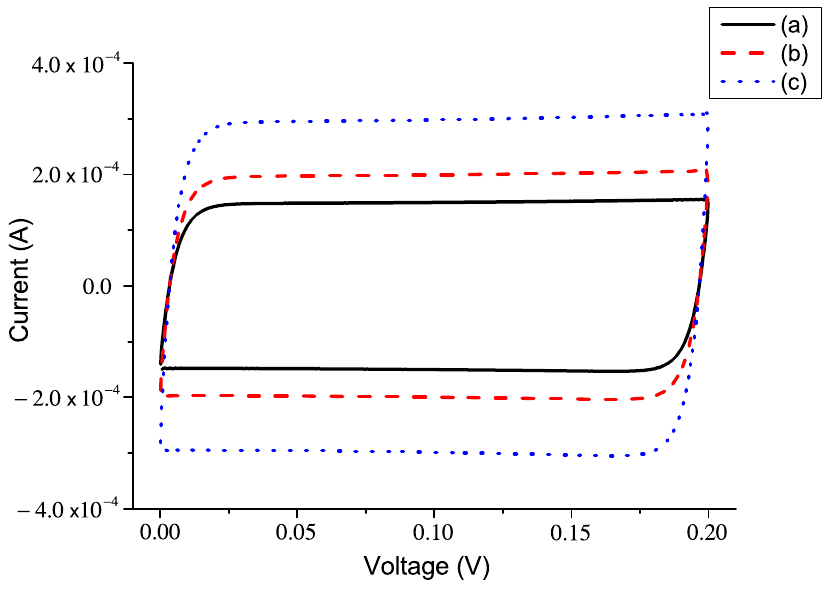
Figure 6. Effect of different adsorption coefficients on the two surfaces on the I = I ( V ) curve. The two electrodes have the same adsorption properties for positive and negative ions. Desorption times τ = 1 s, screening coefficient b = 0.04. The adsorption coefficients on the B electrode are equal to 10 − 6 m/s. On the electrode A, they are equal to 5 × 10 − 7 m/s (a), 10 − 6 m/s (b), and 2 × 10 − 6 m/s